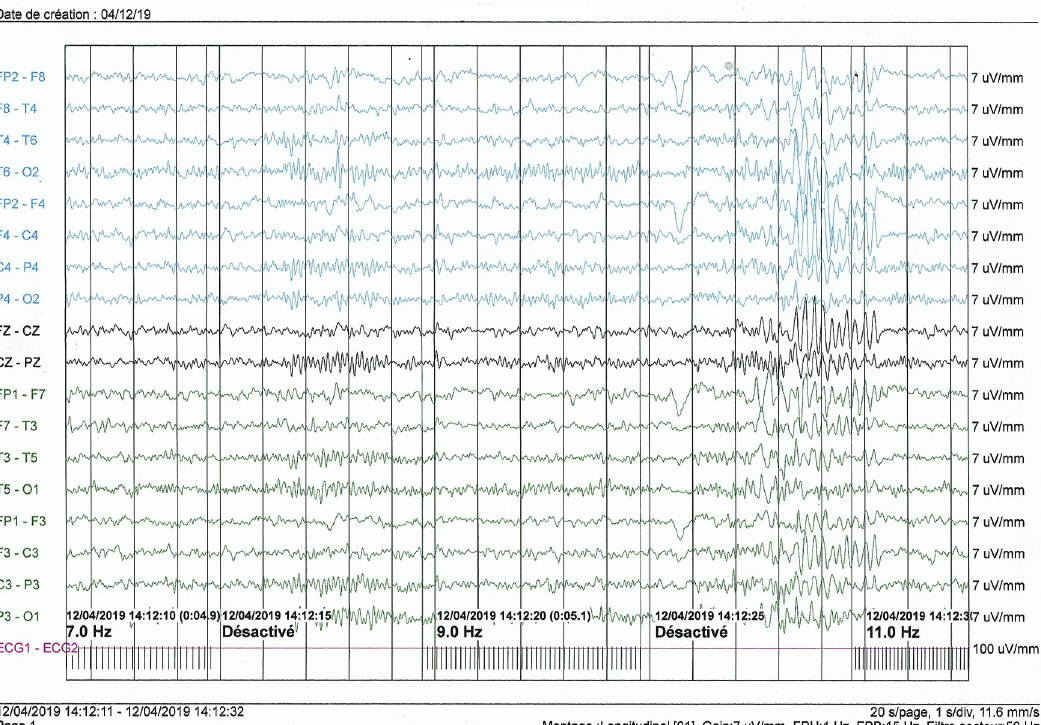
Fig 3. Interictal electroencephalogram of an 8-year-old girl (case